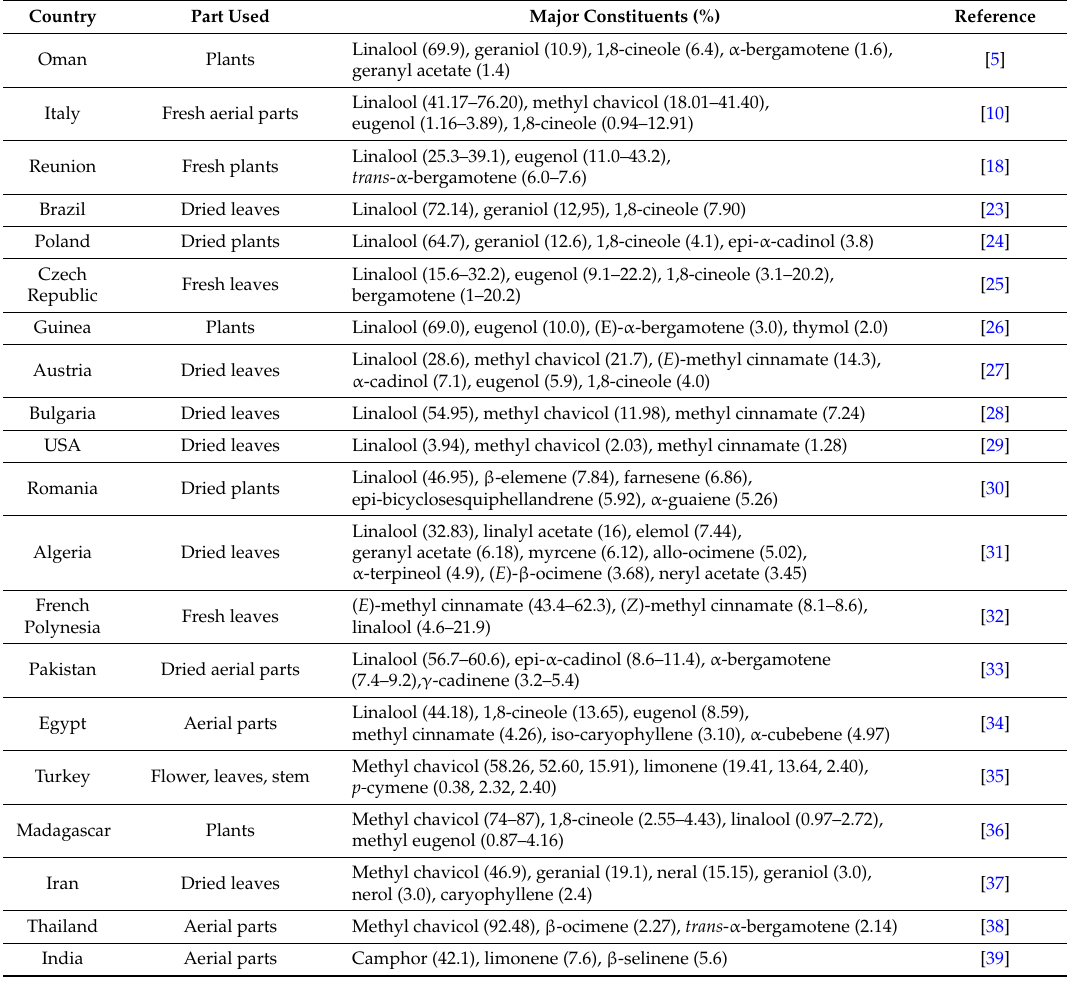
Table 3. Composition of the main compounds of O. basilicum L. essential oil from different